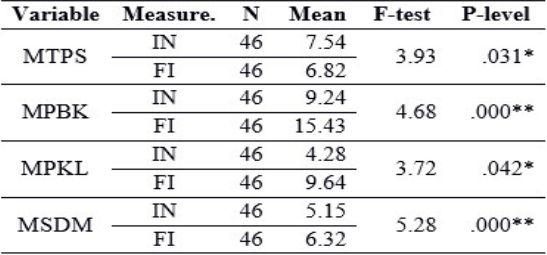
Table 2. Univariate analysis of vari - ance of the motor tests between the initial and the final